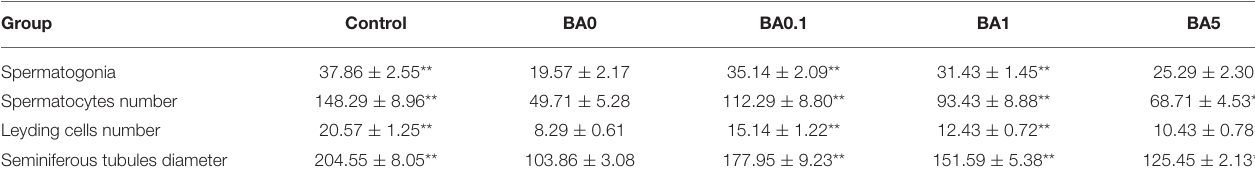
TABLE 2 | Quantification of related parameters in seminiferous